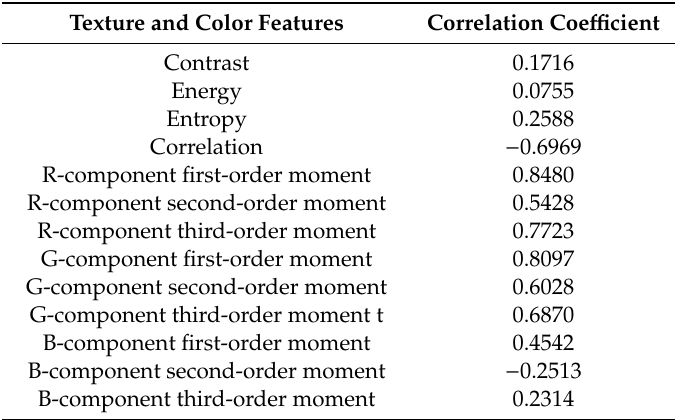
Table 1. Results of correlation analysis of texture and color characteristics of samples with di ff erent severity of